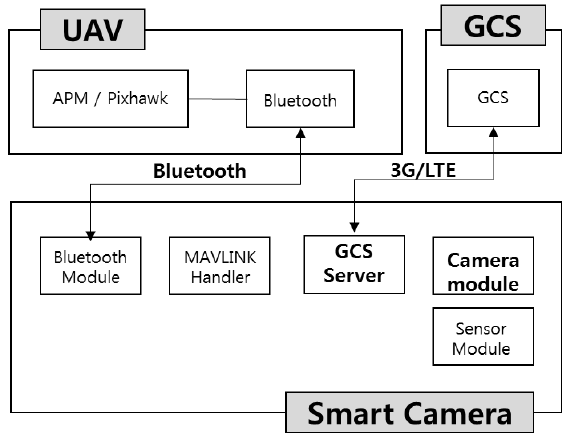
Figure 1. Diagram of Telemetry module